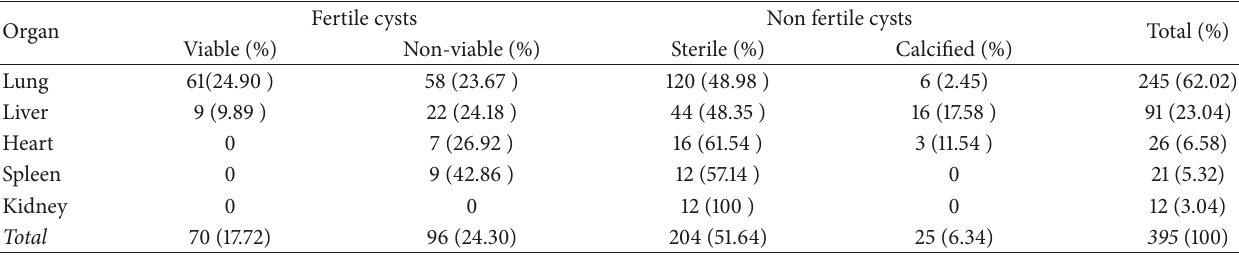
Table 3: Characterization of hydatid cysts in different organs of affected cattle.